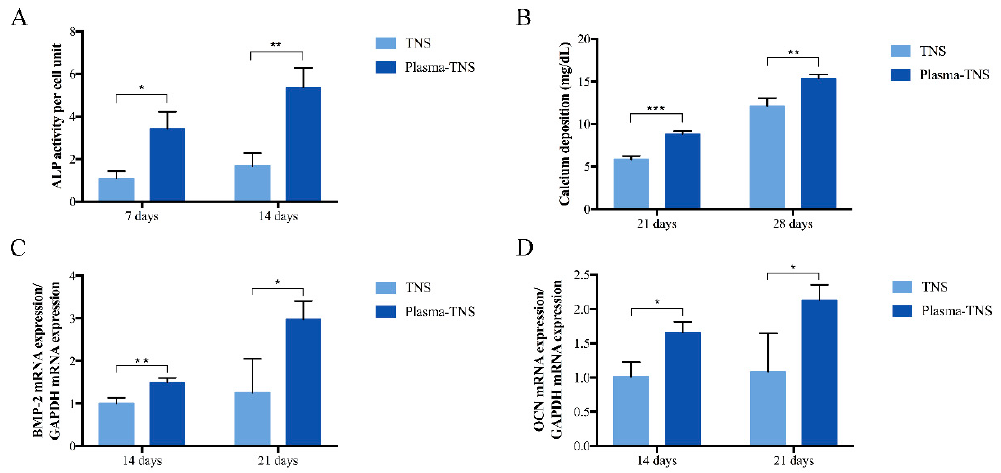
Figure 6. ( A ) Alkaline phosphatase activity, ( B ) calcium deposition, ( C ) bone morphogenetic protein 2 (BMP-2) and ( D ) osteocalcin (OCN) in cells grown on sample disks. Data shown are the means ±SD ( n = 3). *** p < 0.001; ** p < 0.01; * p < 0.05.